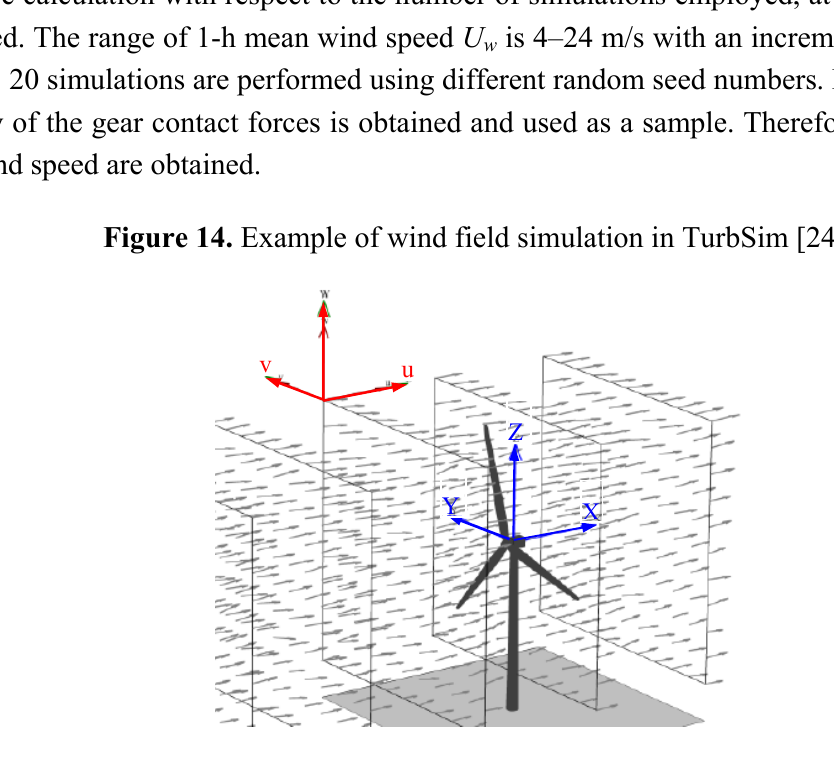
Figure 15. Time series of main shat torques in FAST simulation at the same wind speed with different simulations (random seeds are